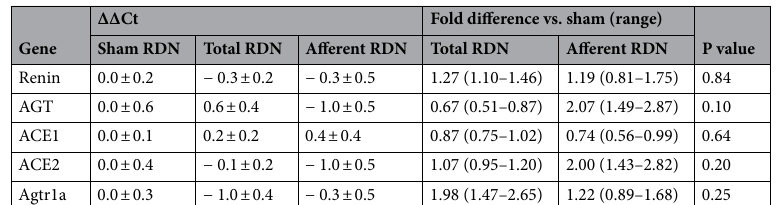
Table 3. Fold difference in kidney RAS gene expression in Lewis Polycystic Kidney (LPK) rats after RDN. RAS renin-angiotensin system, AGT angiotensinogen, ACE angiotensin-converting enzyme, Agtr1a angiotensin type 1a receptor. Data are presented as ΔΔCt with the sham animals used as the reference group. Fold difference (range) was calculated using the 2 −(ΔΔCt ± Standard Error (SE) of the ΔCt) method.